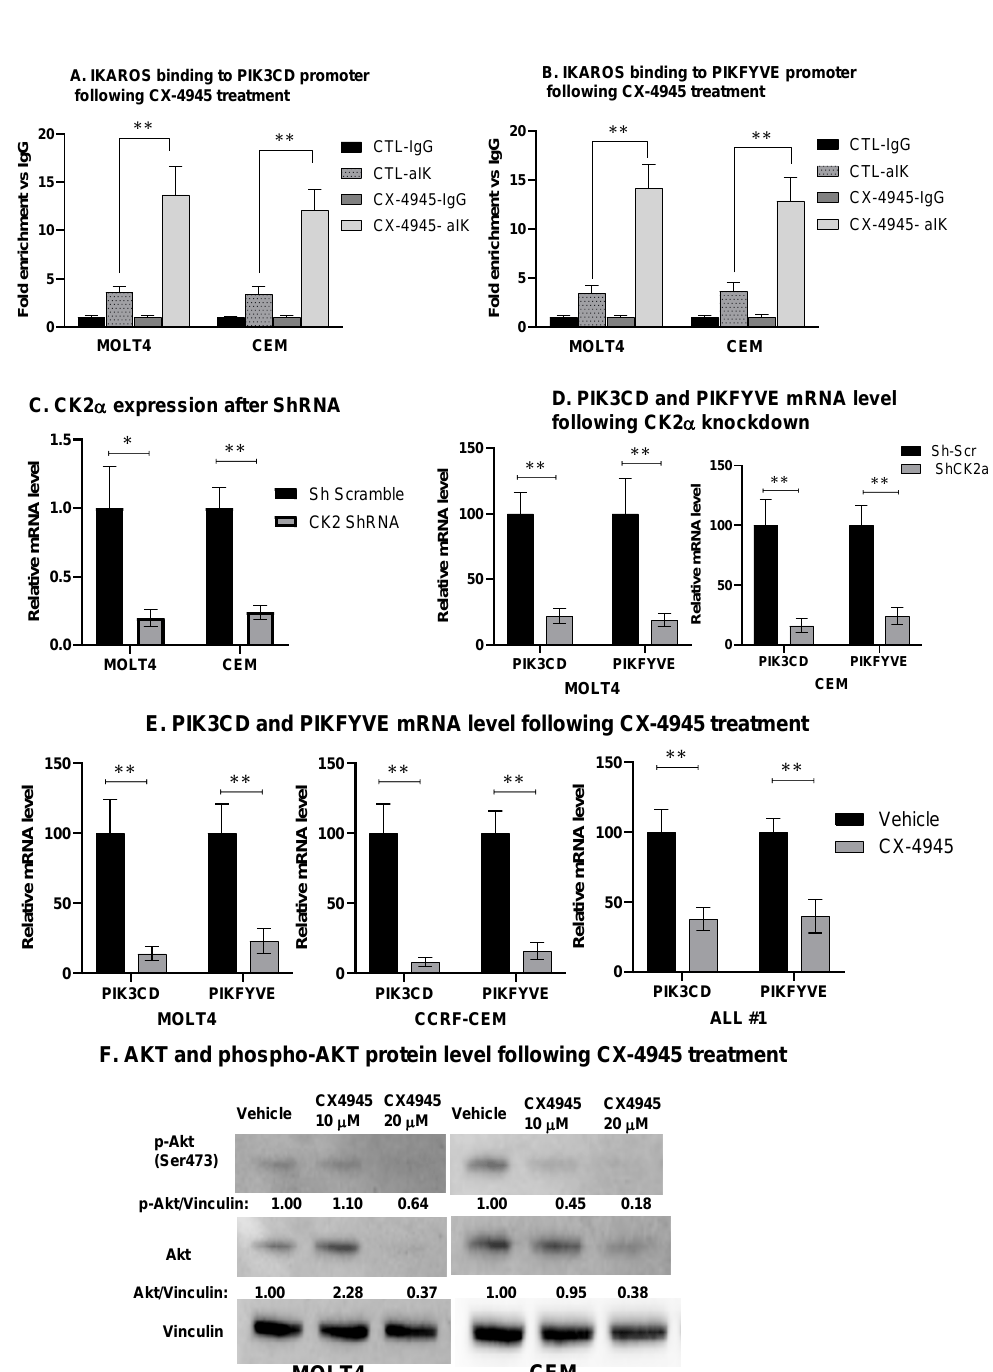
Figure 4. CK2 inhibition restores IKAROS DNA binding and repression of PIK3CD and PIKFYVE . MOLT4, CEM, and T-ALL#1 cells were treated with 10 µ M of CX-4945 for 24 h. IKAROS binding to the ( A ) PIK3CD and ( B ) PIKFYVE promoter region was confirmed using qChIP assay in vehicle- and CX-4945-treated cells. Results are mean ± SD of triplicates representative of one of three independent experiments. Molecular inhibition of CK2 α in CEM and MOLT4 cells was achieved using shRNA. Two of four shRNAs showed a significant and similar decrease in CK2 α . qRT-PCR shows the mRNA level of ( C ) CK2 α and ( D ) PIK3CD and PIKFYVE in CK2-silenced MOLT4 (left panel) and CEM (right panel) cells. CEM and MOLT4 cells were treated with 10 and 20 µ M of CX-4945 for 48 h, and T-ALL#1 primary leukemia cells were treated with 10 µ M of CX-4945 for 12 h. mRNA and protein were extracted. ( E ) The mRNA level of PIK3CD and PIKFYVE was measured in CX-4945-treated CEM, MOLT4, and T-ALL#1 cells. ( F ) AKT and phosphorylated-AKT (p-AKT) protein levels were measured by Western blot. The protein level is expressed relative to vinculin. The p -value summaries are as follows: p ≤ 0.05 (*); p < 0.01